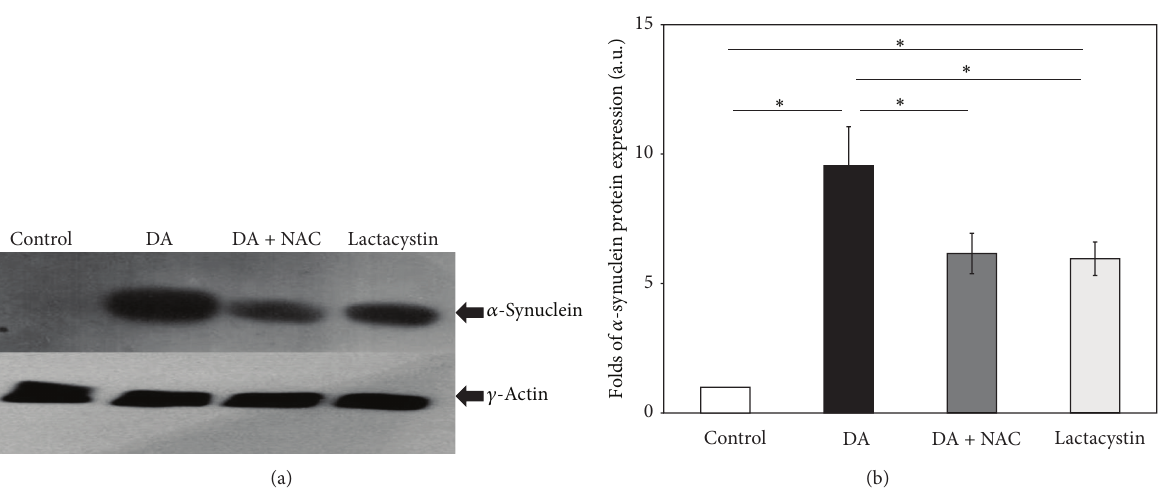
Figure 7: Accumulation of 𝛼 -synuclein in SH-SY5Y cells after DA and lactacystin exposure. SH-SY5Y cells were incubated alone (control), with DA (400 𝜇 M), with lactacystin (5 𝜇 M), and with 400 𝜇 M DA co-treated with 2.5 mM NAC for 24 h. After 24h of incubation, cell lysates were prepared and processed for Western blotting, as described in Section 3. The specificity of the commercially available antibody has been checked against pure recombinant human 𝛼 -synuclein by Western blotting and immunodot blotting (data not shown). (a) The immunoblot is representative of a set of identical experiments repeated four times. (b) Densitometric analysis of the 𝛼 -synuclein bands obtained by the Western blot ( ∗ denotes 𝑃 < 0.001 between the groups).